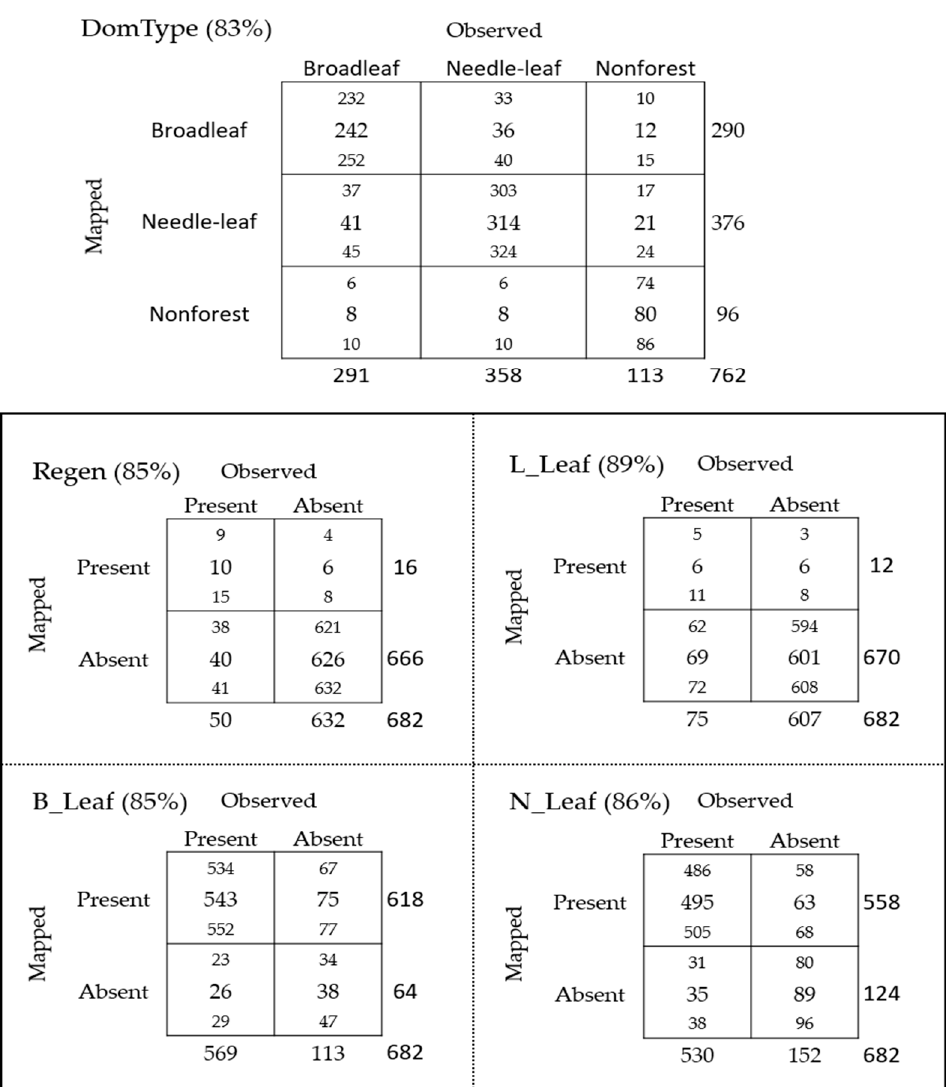
Figure 6. Bootstrapped class frequency for L1 hard classifications. Each cell within a given accuracy assessment contains the mean number of occurrences ( middle ) and the lower ( top ) and upper ( bottom ) 95% confidence limits of occurrences given L1 models and a most likely class (MLC) rule. Overall map accuracies are presented in parentheses to the right of the contingency table name.